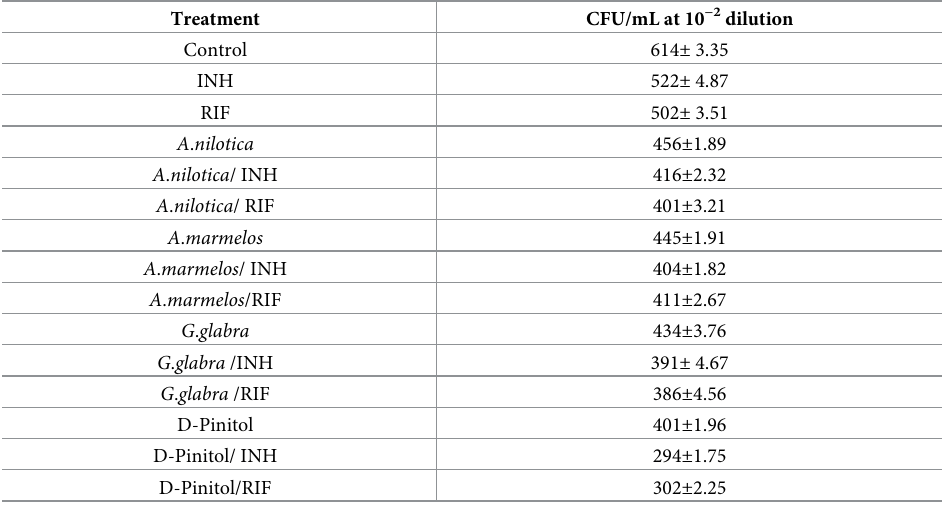
Table 3. CFU/mL for control and treated samples observed at 24 hrs.